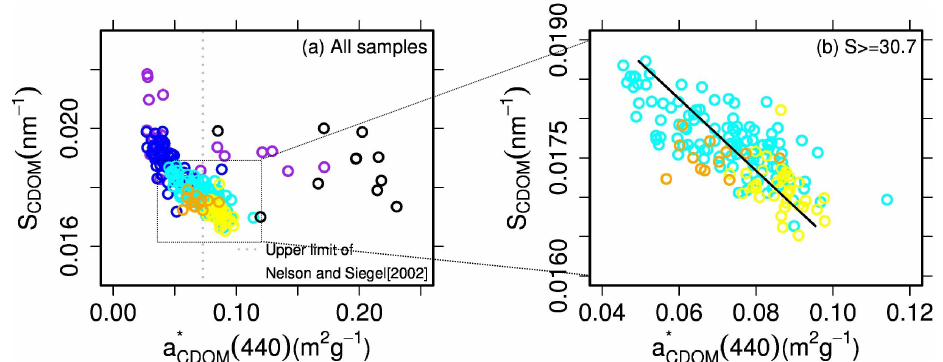
Fig. 10. Variations of S CDOM vs. a ∗ (440) for (a) the whole salinity range and (b) salinity ≥ 30.7. The upper limit from Nelson and CDOM Siegel (2002) is depicted as a dotted line. To obtain those values, a CDOM (440) was estimated from a CDOM (325) by assuming S CDOM = 0 . 015nm − 1 . See Fig. 5 for symbols. A linear fit provides the following relationship: S CDOM = 0 . 021 − 0 . 046*a ∗ p < 0 .